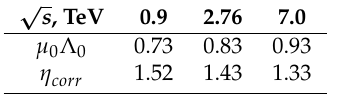
Table 2. The value of the parameters in the exponetial approximations of the type (40) for the two-particle correlation function of a string Λ ( ∆ η ) , obtained by a fitting [14] of the experimental pp ALICE data [13] on FB correlations between multiplicities at three initial energies. √ s ,